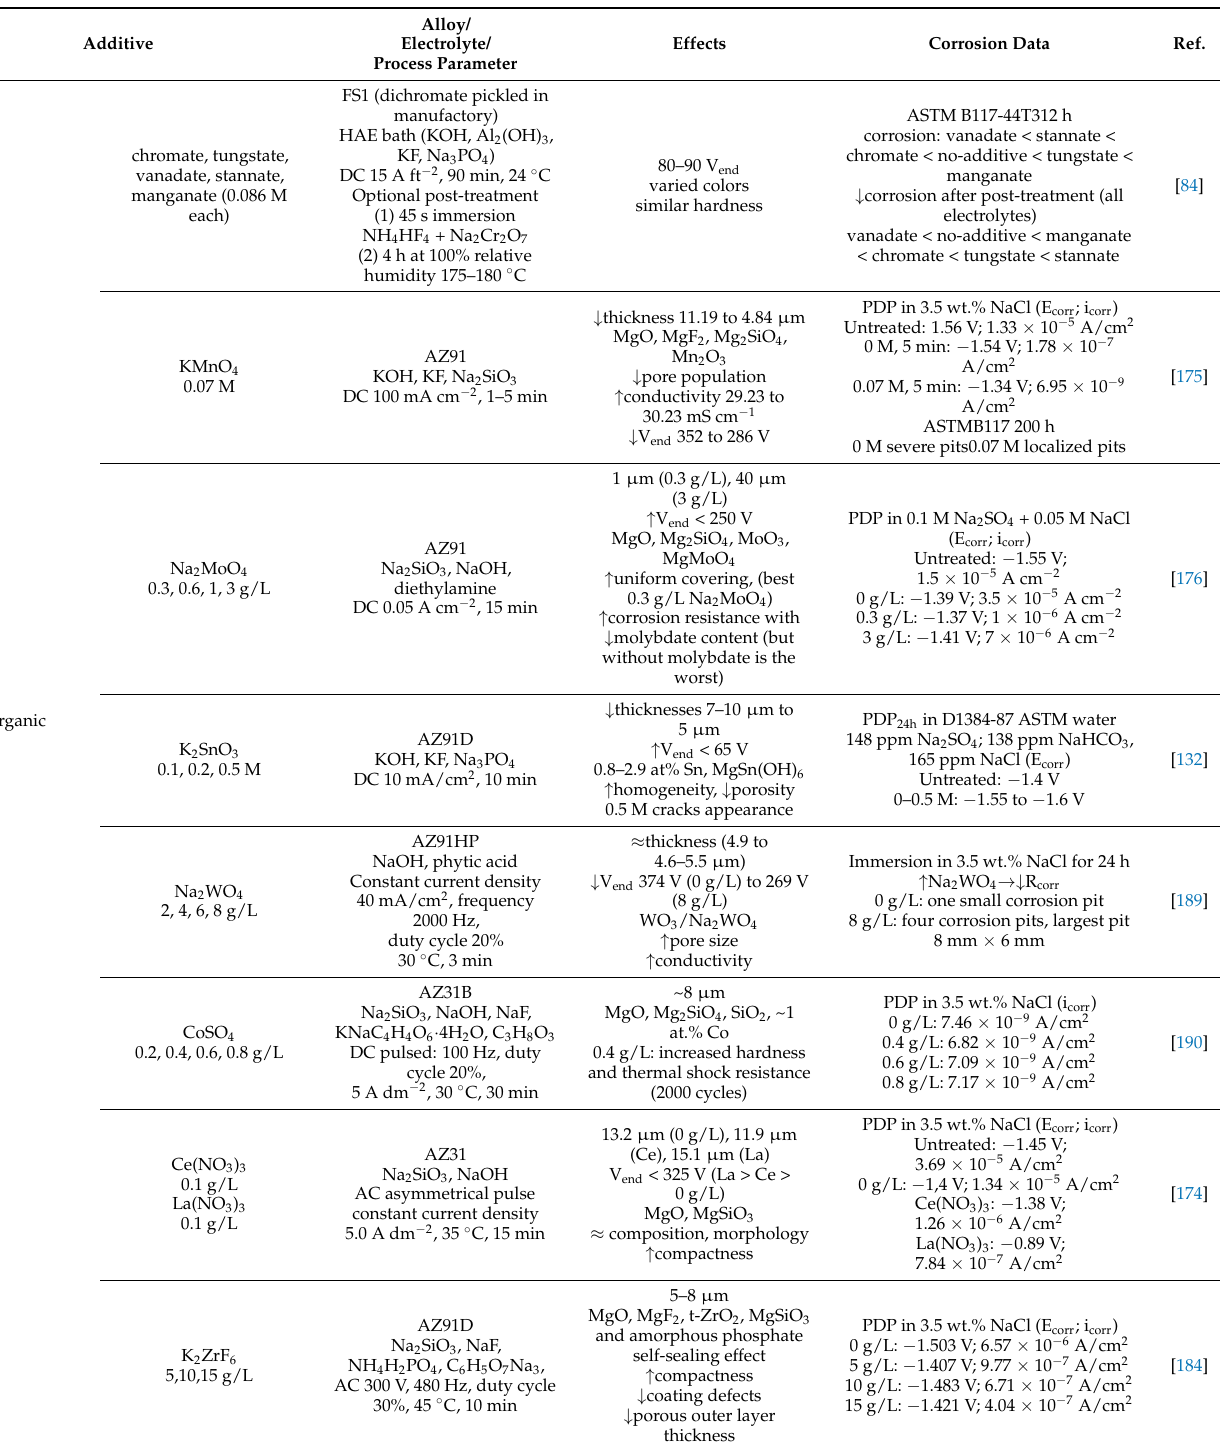
Table 4. Organic and inorganic electrolyte